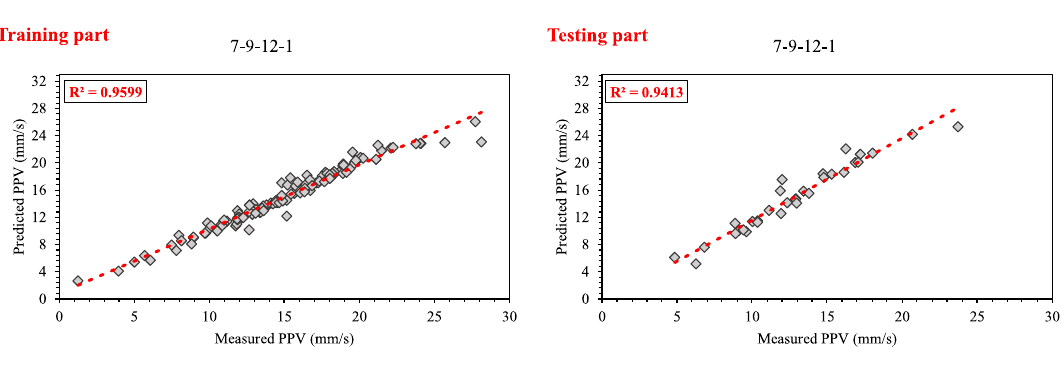
Figure 6. Correlation graph between predicted data (EANNs model) and measured